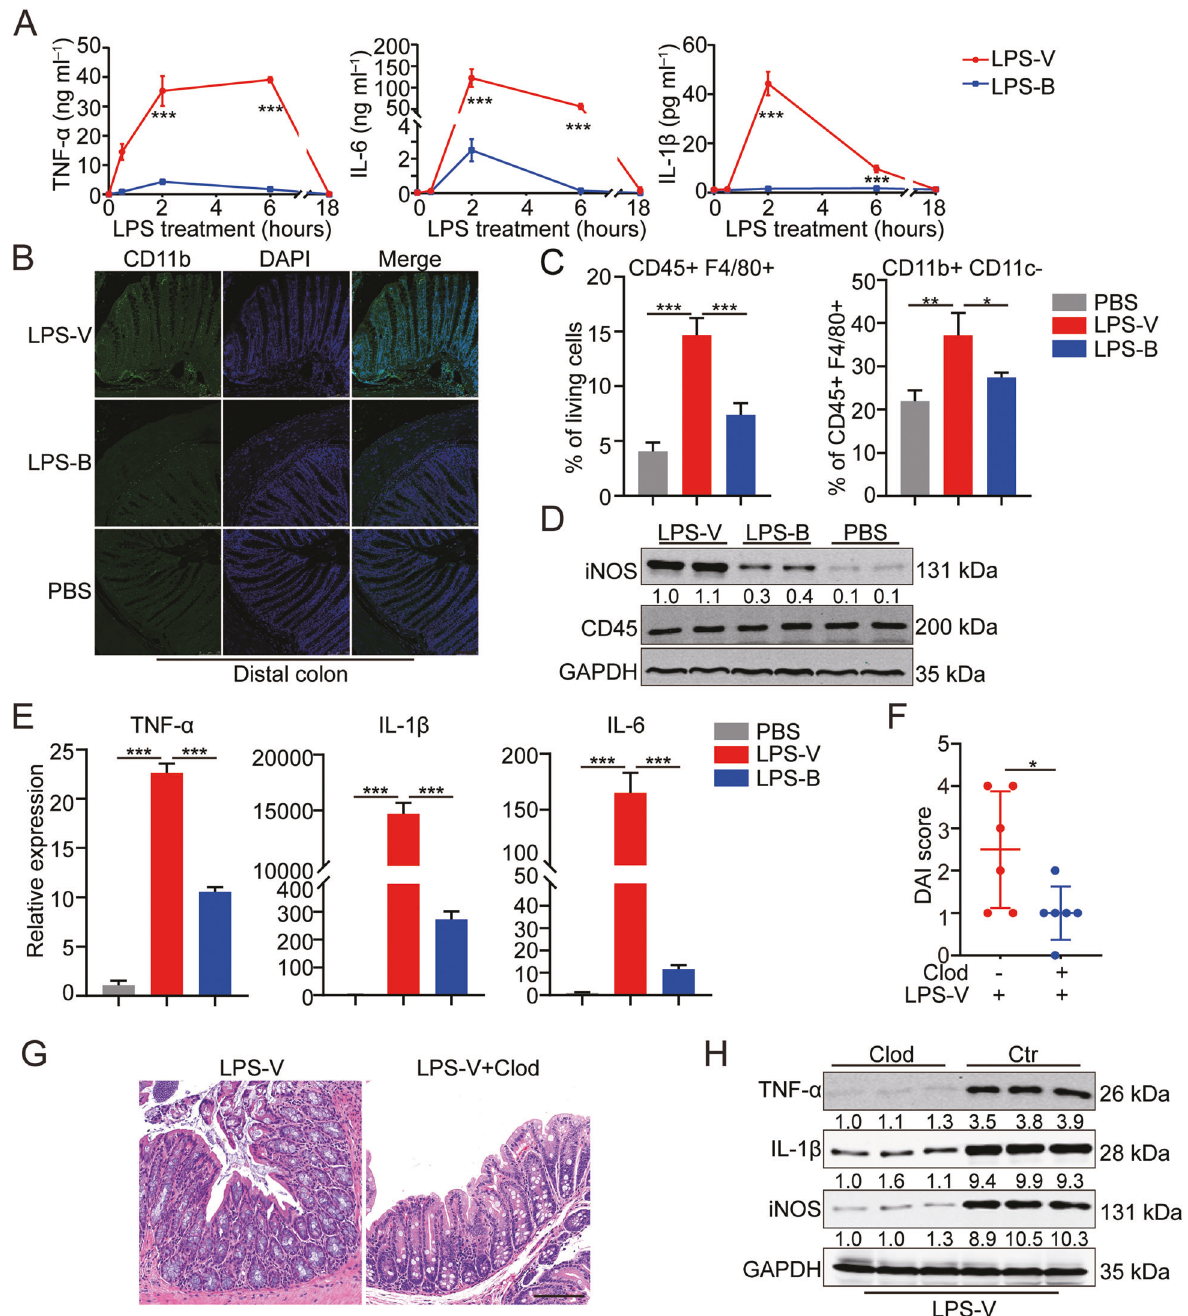
Fig. 4 LPS-V promoted the development of intestinal in fl ammation through activating macrophages. A Supernatant concentration of in fl ammatory cytokines (IL-6, IL-1 β and TNF- α ) in BMDMs treated with LPS-V or LPS-B at indicated time points. B Representative photomicrographs of IF staining showing more CD11b + macrophages in mice of LPS-V group compared to LPS-B or PBS group. Scale bars: 100 μ m. C Flow cytometric histograms indicating the detection of pro-in fl ammatory macrophages in distal colon of mice treated with LPS-V, LPS-B, or PBS. D Western blotting assays showing that LPS-V increased iNOS level in distal colon. E mRNA expression levels of in fl ammatory cytokines (IL-6, IL-1 β , and TNF- α ) in human macrophages treated with LPS-V, LPS-B, or PBS. F The disease activity index (DAI) of mice indicating macrophage depletion using Clod treatment alleviated the effects of LPS-V. G Representative photomicrographs showing macrophage depletion using Clod treatment alleviated the effects of LPS-V. on colon tissue. Scale bars: 100 μ m. H Western blotting assays showing macrophage depletion using Clod treatment decreased IL-1 β , TNF- α and iNOS level in distal colon. All data are expressed as mean ± SD. * P < 0.05; ** P < 0.01; *** P < 0.001. In previous studies, abnormal changes in intestinal fl ora were DISCUSSION found in HAEC patients. We also found a lower diversity of gut Maintaining the homeostasis of microbial communities in the micro fl ora in different intestinal segments of HAEC patients human gastrointestinal tract is signi fi cant for health, and the compared with that of HSCR patients. In our previous study, the alteration of intestinal fl ora is associated with numerous health abundance of Veroniella in the intestinal tract of HAEC patients was disorders [28, 29]. Cell Death Discovery (2022)